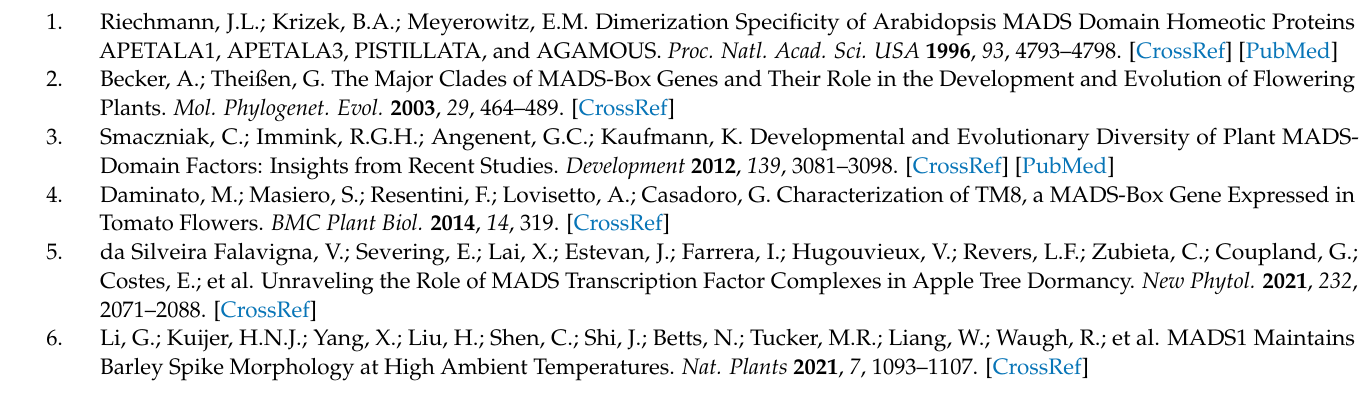
the hop genome. Table S2: RNA-seq libraries used to guide AUGUSTUS gene prediction and transcriptional profiling. Table S3: Gene Ontology terms of the hop MADS-box gene family. Figure S1: Phylogenetic tree of MIKC*-type MADS-box proteins of H. lupulus (2, in red font) , Arabidopsis (6, in black font). Figure S2: RNA-Seq reads aligned on the gene 000453F.g47 . Figure S3: Motif distribution of type-I MADS-box proteins in hop. Protein sequences are represented by black lines, and the conserved motifs are represented by colored boxes. Figure S4: Motif distribution of hop β -subfamily MADS-box proteins. Protein sequences are represented by black lines, and the conserved motifs are represented by colored boxes. ( A ) Logo of MADS-box domain. ( B ): Motif distribution of the hop β -subfamily MADS-box proteins. ( C ) Amino acid residues within MADS-box domains. Figure S5: Expression profile of the hop MADS-box genes in three RNA-Seq libraries from cones, leaves, and glands. Figure S6: Gene Ontology classification of MADS-box genes in hop and Arabidopsis . Figure S7: RNAseq reads that are uniquely mapped on six novel MADS-box genes